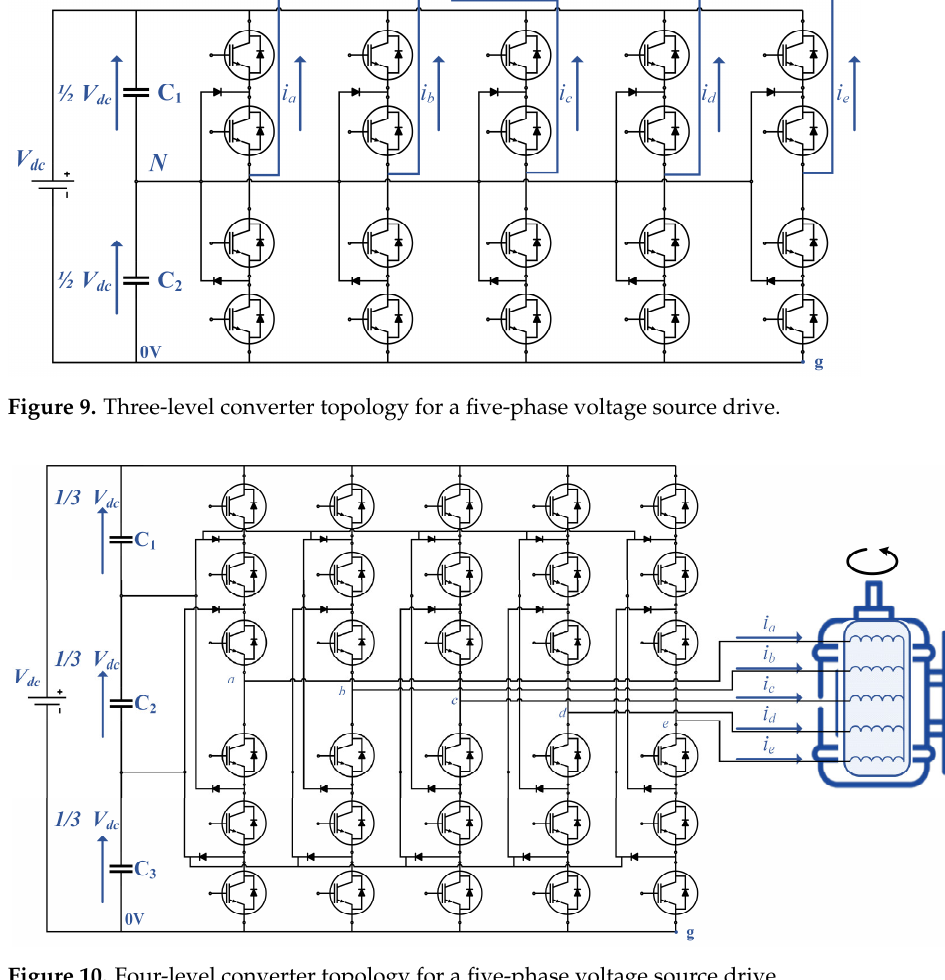
Figure 10. Four-level converter topology for a five-phase voltage source drive.